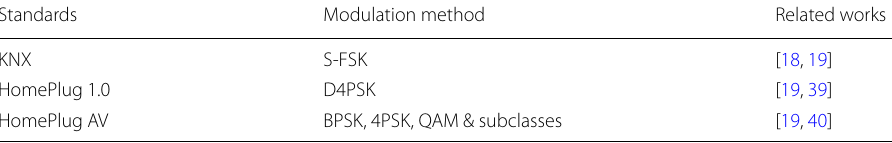
Table 3 Regulator standards for broadband PLC and relevant modulation methods